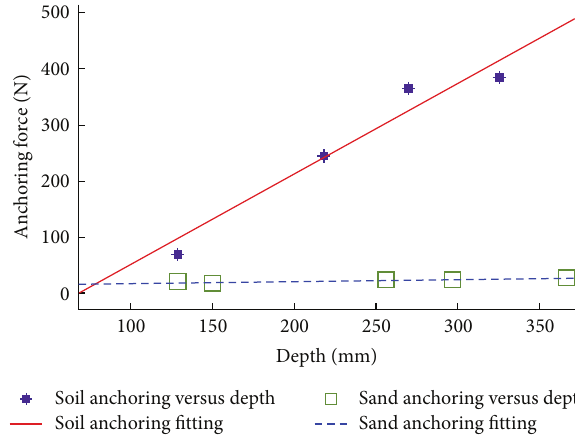
Figure 7: Anchoring force versus depth in soil and sand.